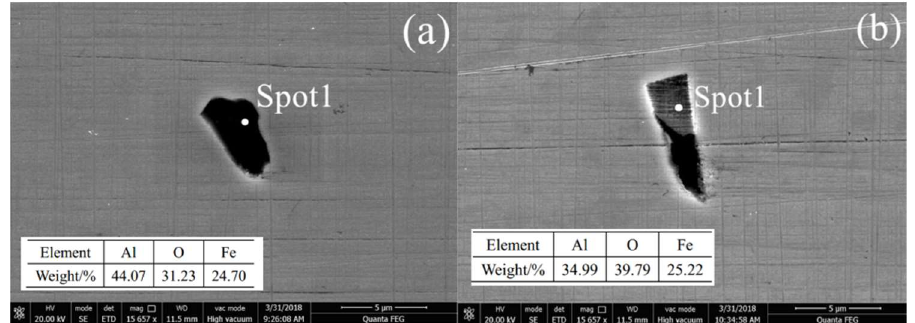
Figure 8. The morphology of Al 2 O 3 inclusions. ( a ) irregular Al 2 O 3 inclusion; ( b ) triangular Al 2 O 3 inclusion.